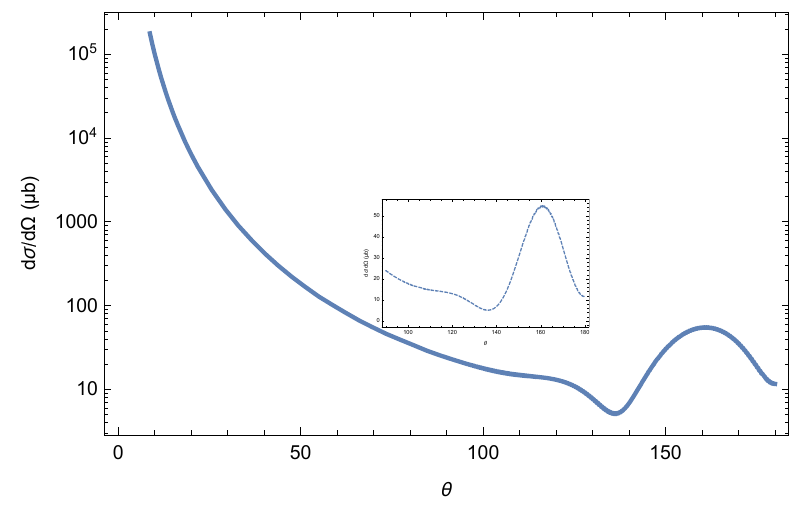
Figure 2. Elastic scattering ion monopole cross section ( µ b) a for a beam energy of 1 GeV/nucleon spin 1/2 ions ( 41 Ca) by a fixed spinless magnetic monopole. The inset shows in dashed the details of 20 the backward region of experimental